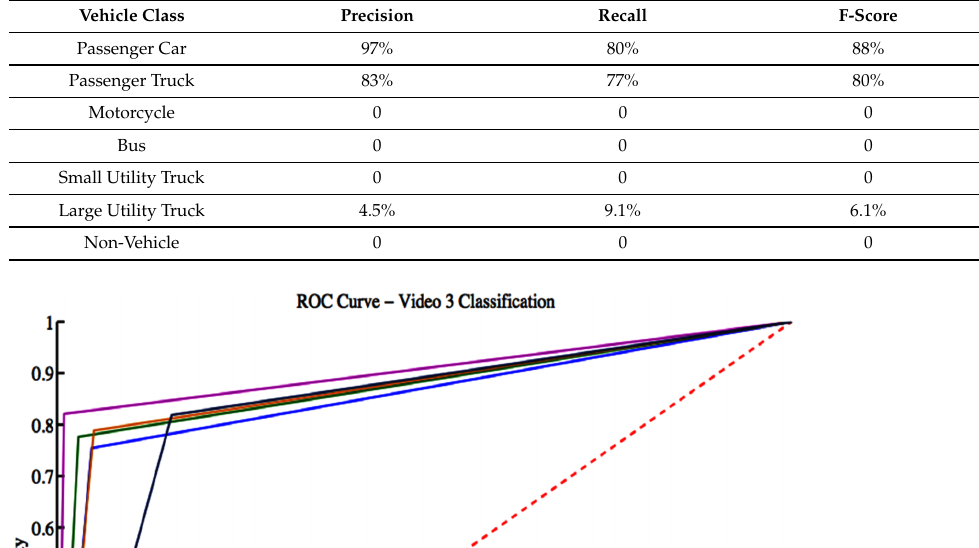
Table 17. Different evaluation metrics for detected vehicles in multiple vehicle clusters within Video 3.